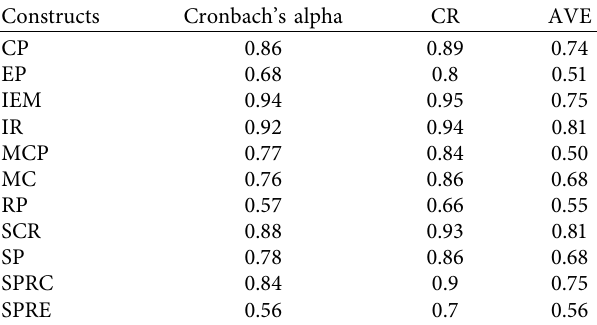
Table 5: Reliability and convergent validity.